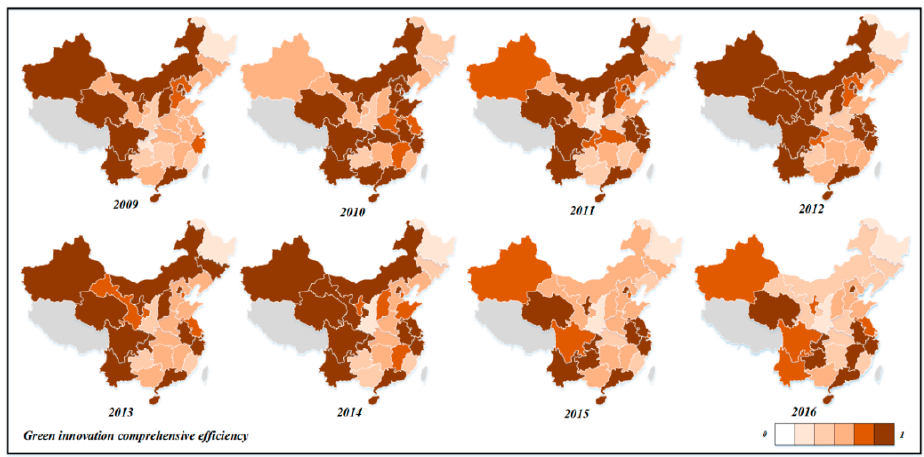
Figure 9. The evolution map of industrial enterprises’ green technology innovation comprehensive efficiency in China (2009 – 2016).